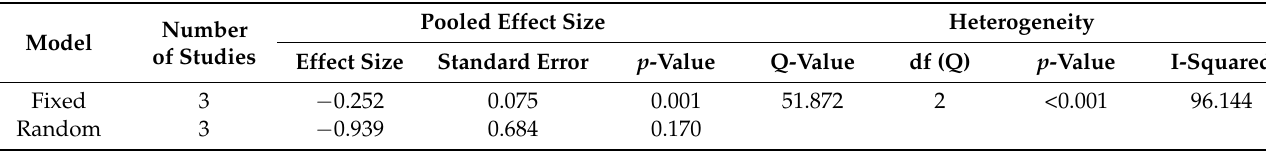
Table 19. Heterogeneity test results of studies on the influence of indoor plants on response time.